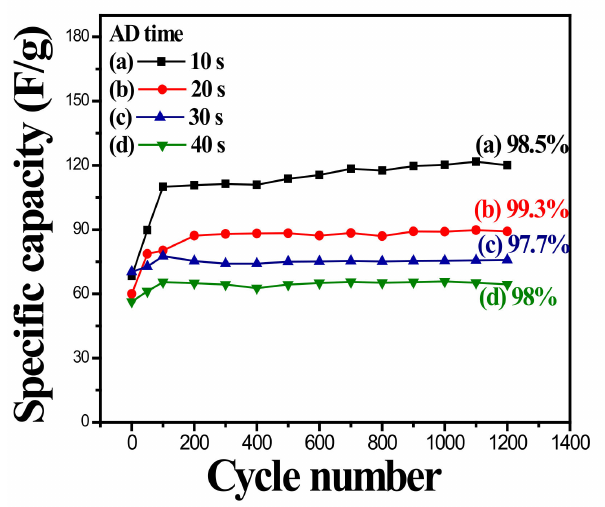
Figure 9. Specific capacitance of MnOx-coated ZnO nanorod measured in 1.0 M Na 2 SO 4 electrolyte at a scan rate of 100 mV / s at various anodic deposition time as a function of cycle